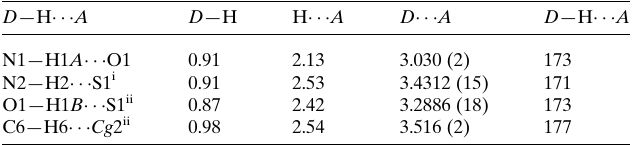
Table 1 Hydrogen-bond geometry (A˚ , (cid:3) ).